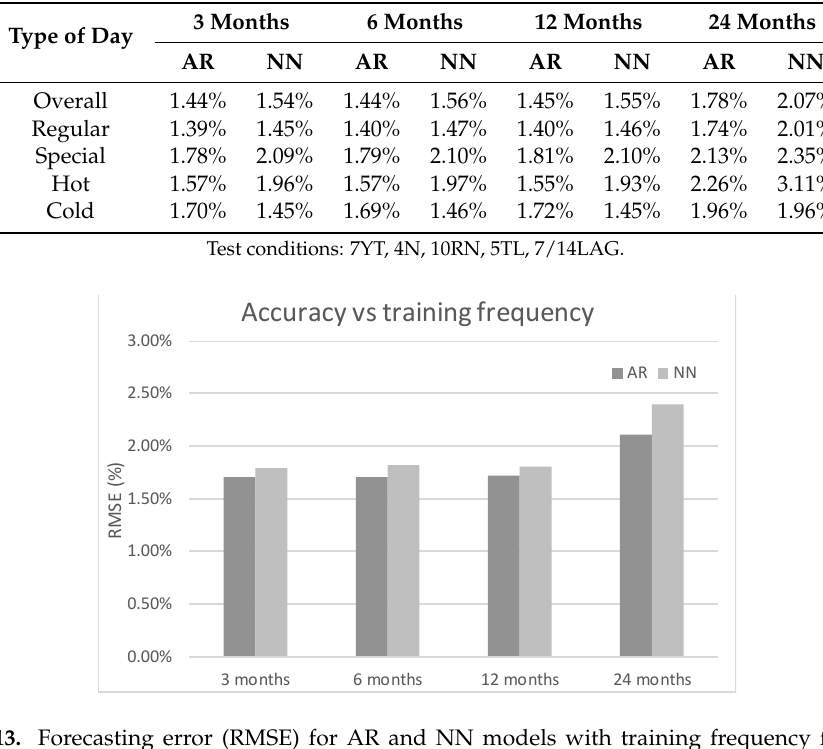
Figure 12. Overall forecasting error (RMSE) and execution time with different redundant networks.